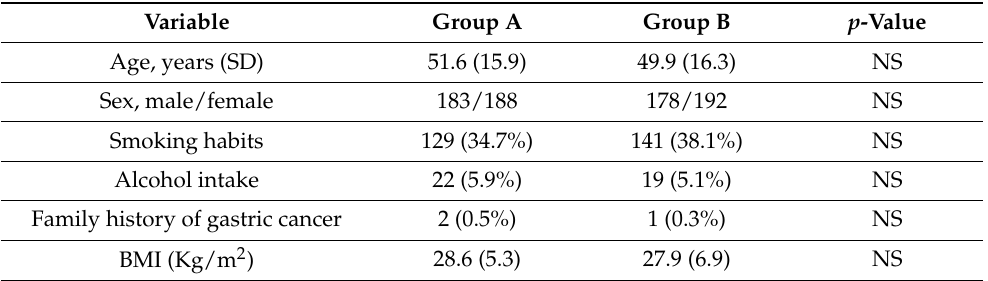
Table 1. Baseline characteristic of the study population.